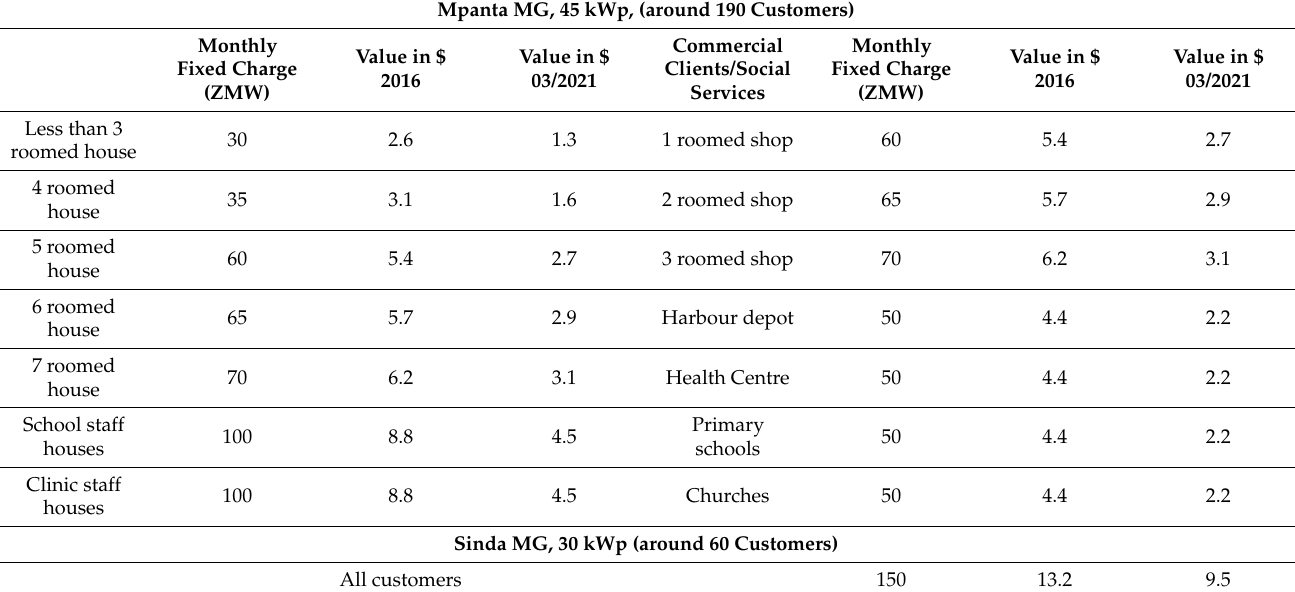
Table 4. Tariff structures Mpanta and